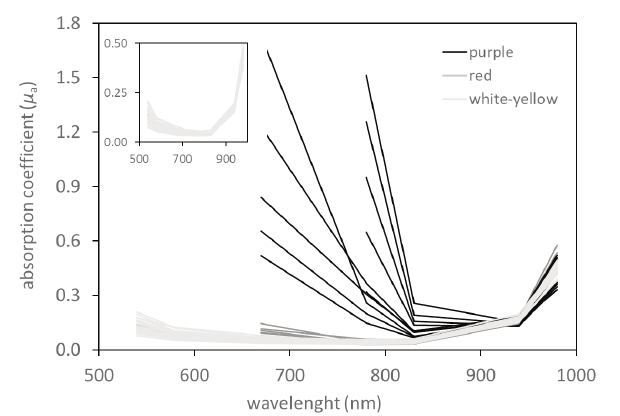
Fig. 1 ­ Absorption spectra of the five selected purple­red­yel­ low­white fleshed tubers. The inset figure shows the variability of the absorption spectra for white­ and yel­ low­fleshed genotypes.